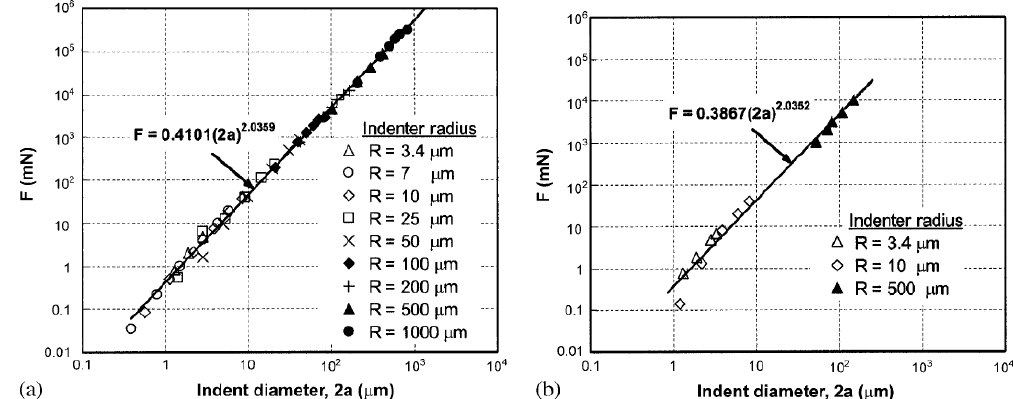
Figure 35. ( a ) Results of FEM simulations showing the variation of the indentation force, F with indent diameter, 2a for different indenter radii, R; ( b ) Results of indentation experiments showing the variation of the indentation force, F with indent diameter, 2a for different indenter radii, R [131]. Reproduced with permission from Y. Liu et al., Journal of the Mechanics and Physics of Solids; published by Elsevier,